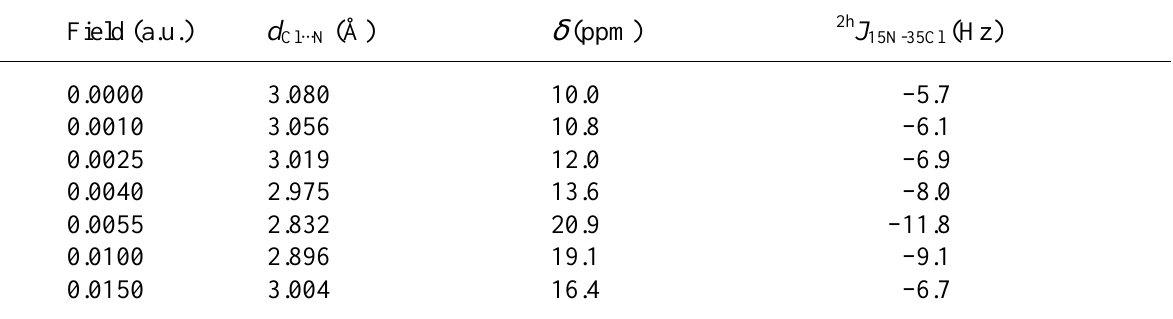
Table 3 . Equilibrium Cl···N distances, proton chemical shifts and 2h J functions of external field